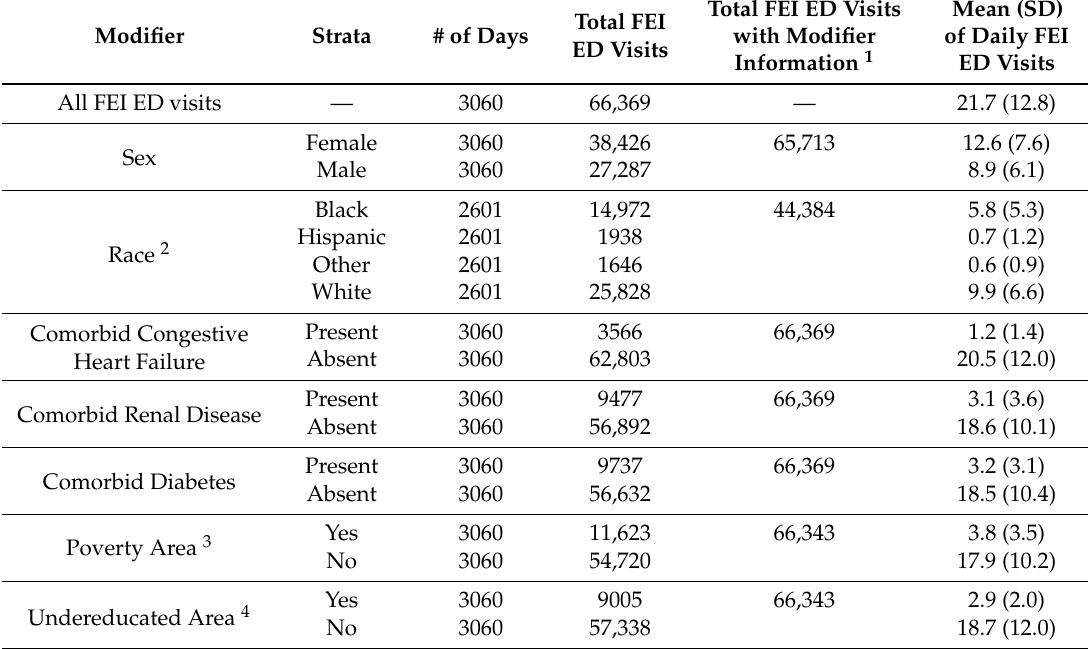
Table 4. Descriptive statistics of fluid and electrolyte imbalance ED visits stratified by modifiers